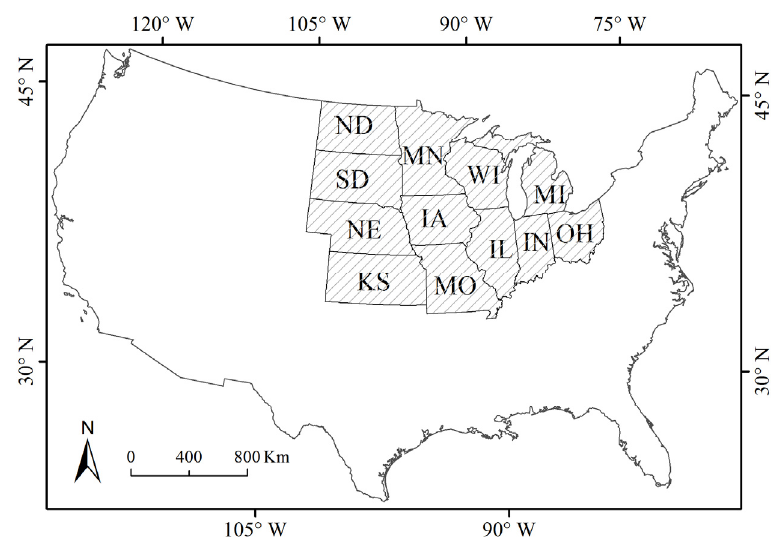
Figure 1. The study area of the Midwestern US comprises 12 states.